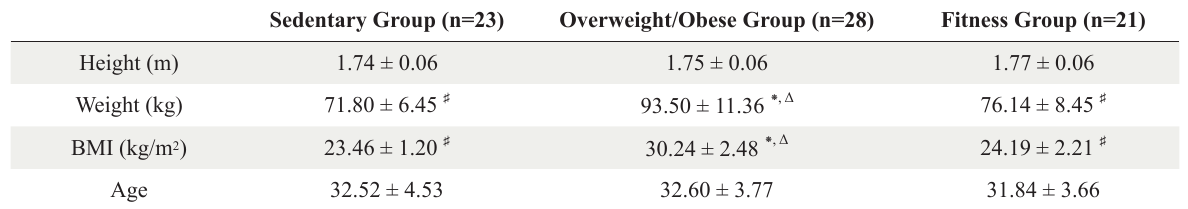
Demographic characteristics of the groups are illustrated in the